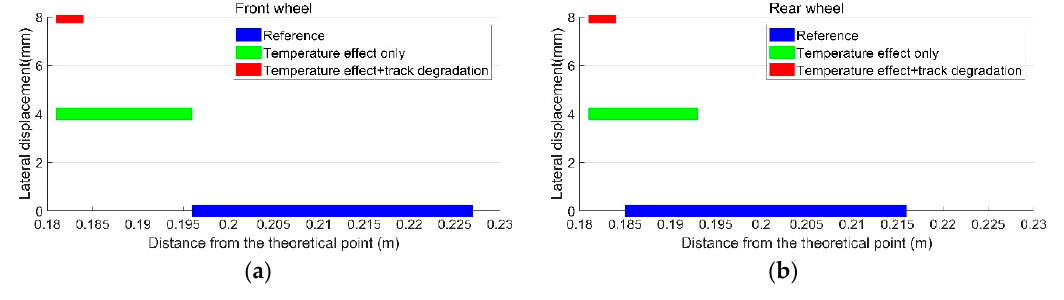
Figure 21. Transition regions of the crossing. ( a ) Front wheel; ( b ) rear wheel.